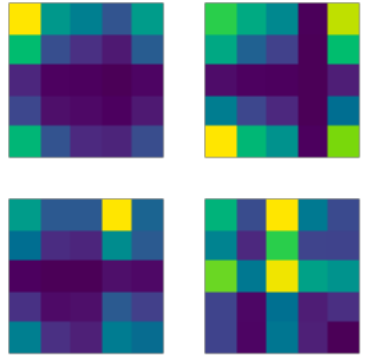
Figure 8. GAF-CNN output.